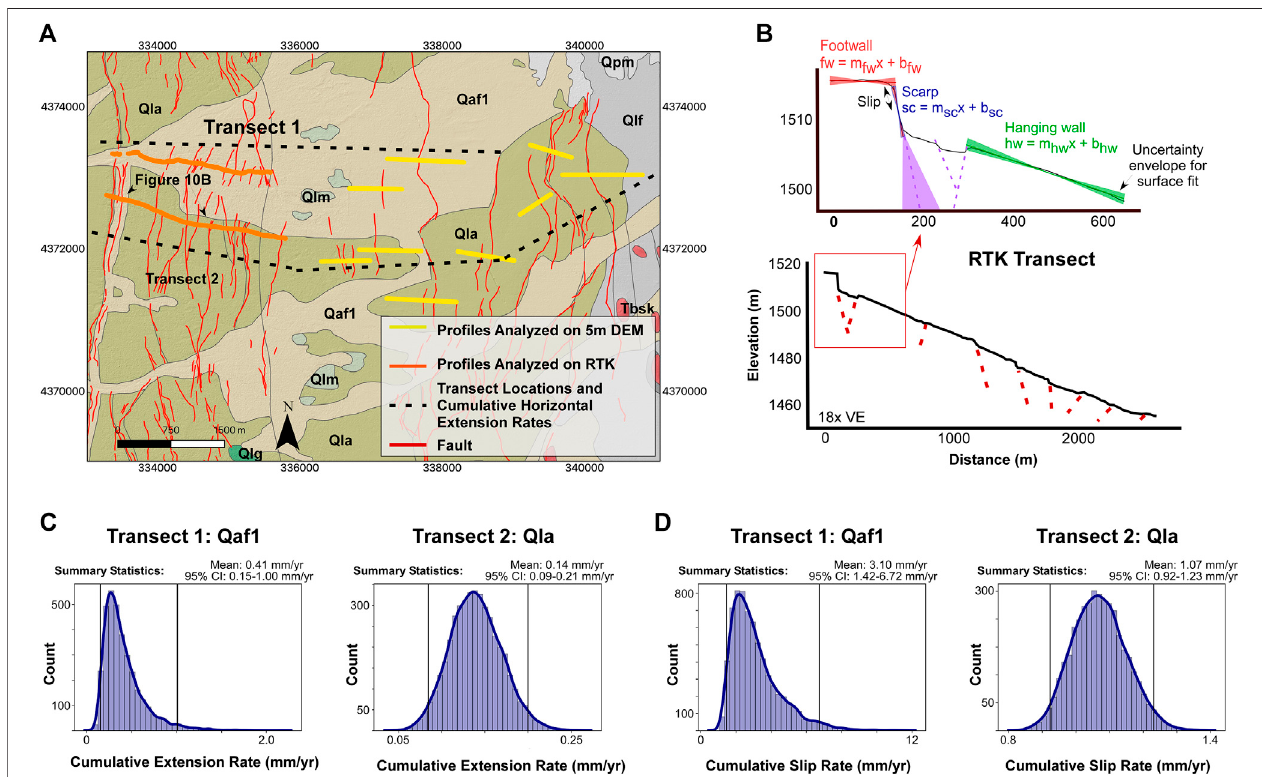
FIGURE10 | Summedextensionratesmeasured acrosstwo transects ofthe DMFZ within units Qaf1 and Qla. (A) Locationof thetwo transect lines, mapped fault scarps, and individual pro fi les used to construct the elevation pro fi les along each transect. The pro fi le combines RTK survey (orange lines) and 5-m DEM elevation data (yellow lines); pro fi le locations were chosen as close to the transect lines as possible and are oriented perpendicular to the local scarp trend. (B) An example pro fi le (locationindicatedin A )fromtheQaf1surfacewithschematicfaultsincross-sectionandfaultscarpcomponentsforonescarppro fi le. (C) Summedextensionrates across the two transects in (A) in mm yr − 1 for faults with steep dips (75 – 90 ° ). (D) Summed extension rates across the two transects in (A) resolved onto a 0 ° -dipping detachment.